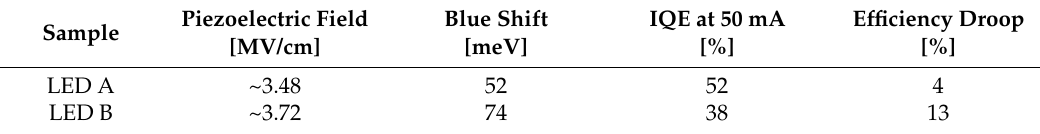
Table 1. Measured data of LED A and LED B